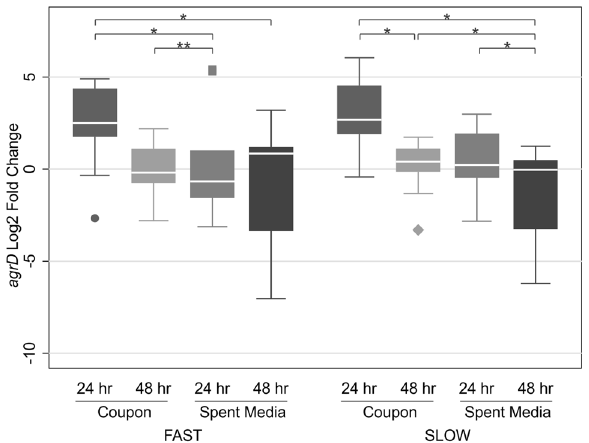
Figure 3. agrD expression (log 2 fold change) at 24 and 48 h in coupons and spent media. No statistically significant difference in agrD expression between slow and fast isolates. Comparison of paired conditions or timepoints displayed significant difference, specifically C24hr Fast and SM24hr Fast (Z = 2.073, p = 0.0382), C48hr Slow and SM48hr Slow (Z = 1.992, p = 0.0464), C24hr Slow and C48hr Slow (Z = 2.490, p = 0.0128), SM24hr Slow and SM48 Slow (Z = 2.192, p = 0.0284), C24hr Fast and SM48hr Fast (Z = 2.341, p = 0.0192), C48hr Fast and SM24hr Fast (Z = 2.970, p = 0.0030) and C24hr Slow and SM48hr Slow (Z = 2.521, p = 0.0117). *p < 0.05;